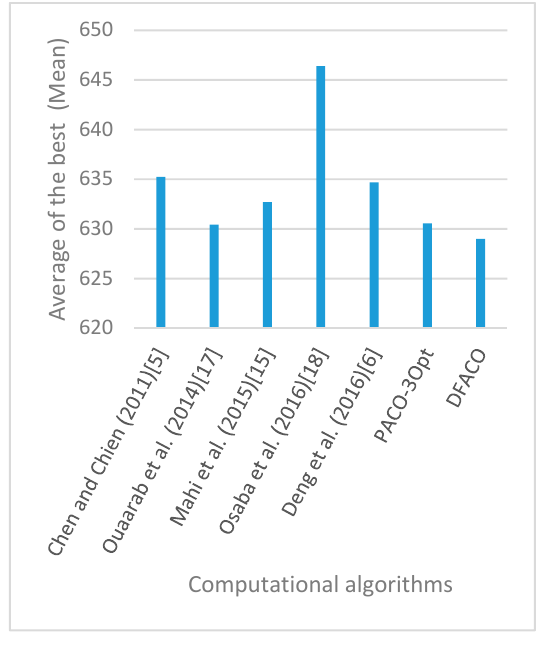
Figure 10. Average of best solutions obtained for instance eil101 by all algorithms.